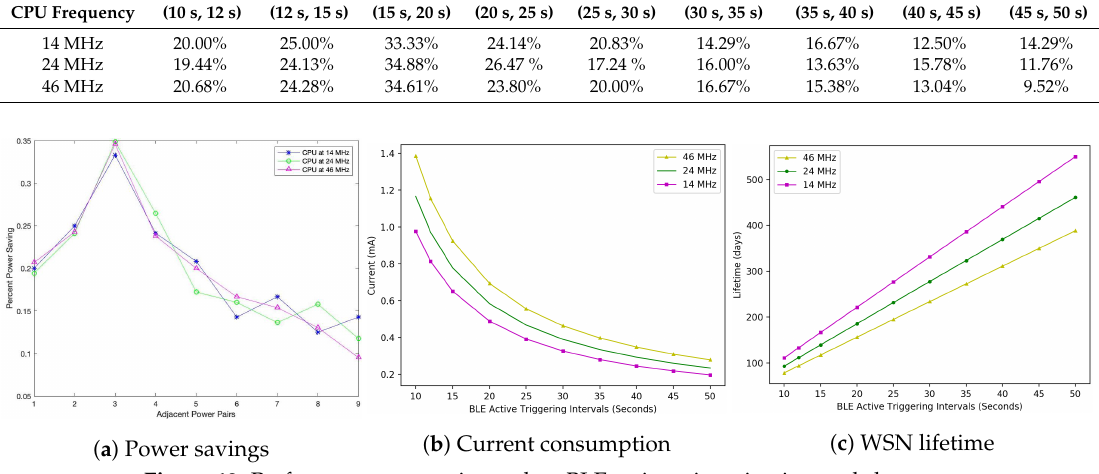
Figure 12. Performance comparison when BLE active triggering interval